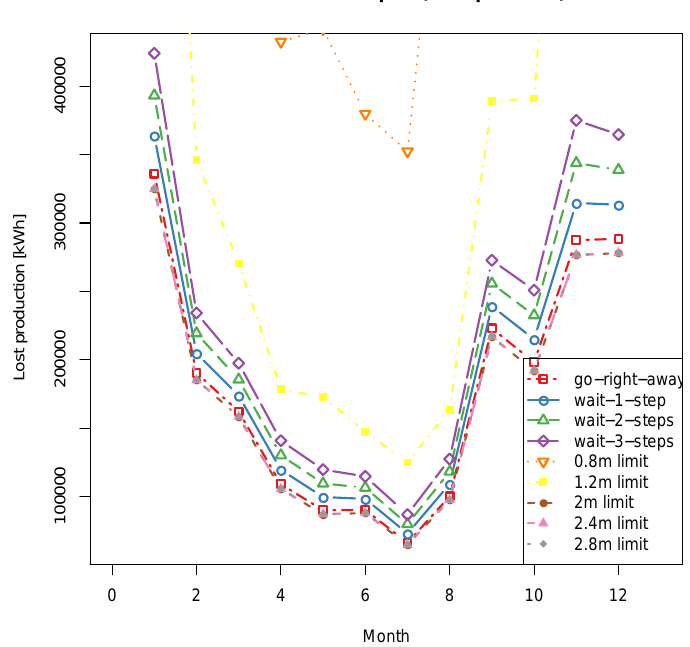
Figure 7. Lost production in kWh for a minor repair of the electrical system, with a repair time of 5 h. The policies with a higher (less restrictive) wave height threshold for vessel access show slightly lower losses in production than the original